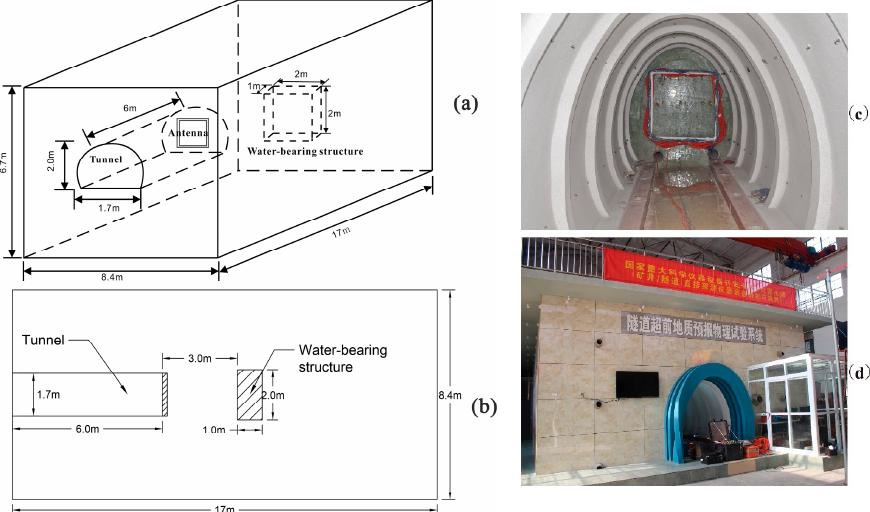
Figure 7. Diagram of the model tunnel and water-bearing structure. ( a ) 3-D diagram; ( b ) longitudinal profile of the test model; ( c ) small-coil sensor; ( d ) physical test system for geological prediction of tunnels.